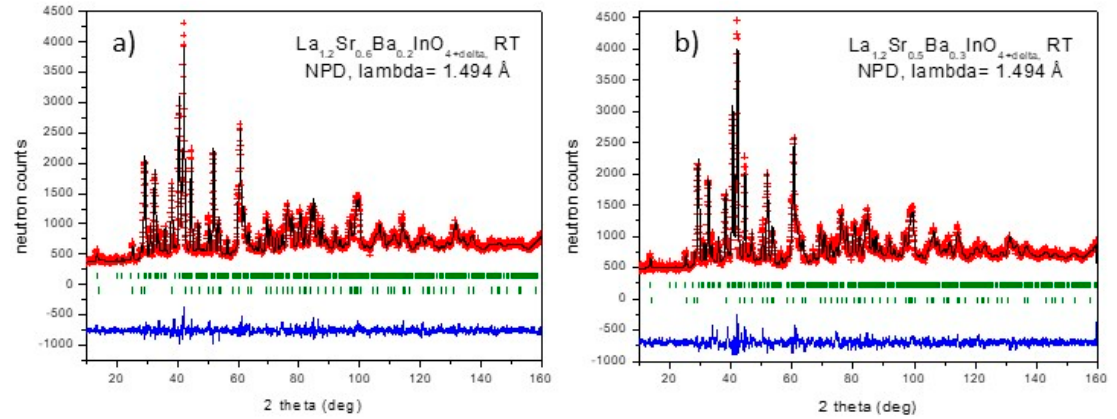
Figure 3. Observed (crosses), calculated (full line) and difference (at the bottom) NPD profiles for ( a ) La 1.2 Sr 0.6 Ba 0.2 InO 4 + δ , and ( b ) La 1.2 Sr 0.5 Ba 0.3 InO 4 + δ , at 25 ◦ C, refined in the Pbca space group. The vertical markers correspond to the allowed Bragg reflections for the main phase; the second series of markers corresponds to La 2 O 3 minor impurity phase. Table 2. Structural parameters and discrepancy factors after the Rietveld refinement of La 1.2 Sr 0.6 Ba 0.2 InO 4 + δ in the space group Pbca from NPD data. Atoms x = 0.0 * x = 0.2 x =